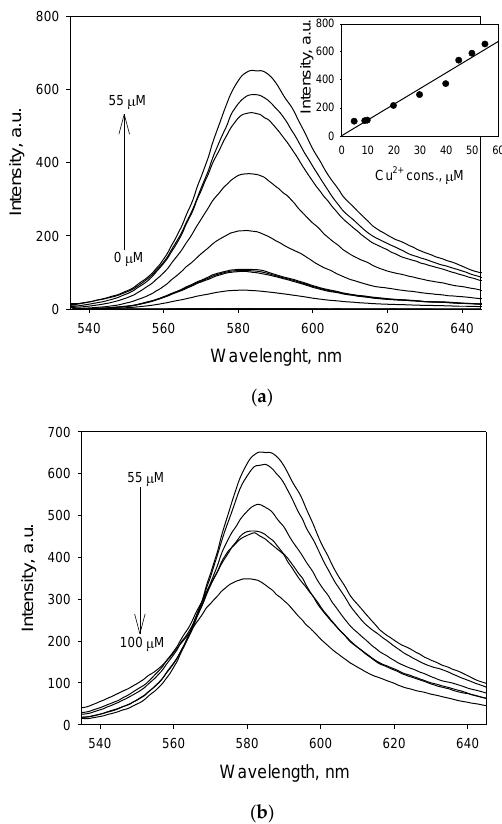
Figure 4. Fluorescence spectra ( λ ex = 530 nm) of RECM (50 µM) in CH 3 CN in the presence of ( a ) 0–55 µM and ( b ) 55–100 µM of Cu 2+ , respectively. Inset: Linear fluorescence response of RECM (50 µM) in CH 3 CN within the Cu 2+ concentration range of 1–55 µM.